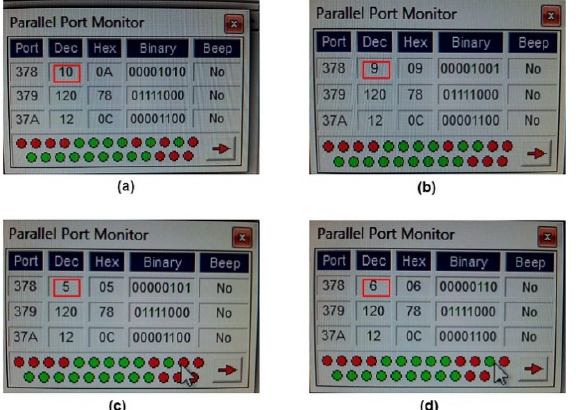
Figure 11. Parmon’s parallel port monitor application and motor functioning: ( a ) decimal value 10